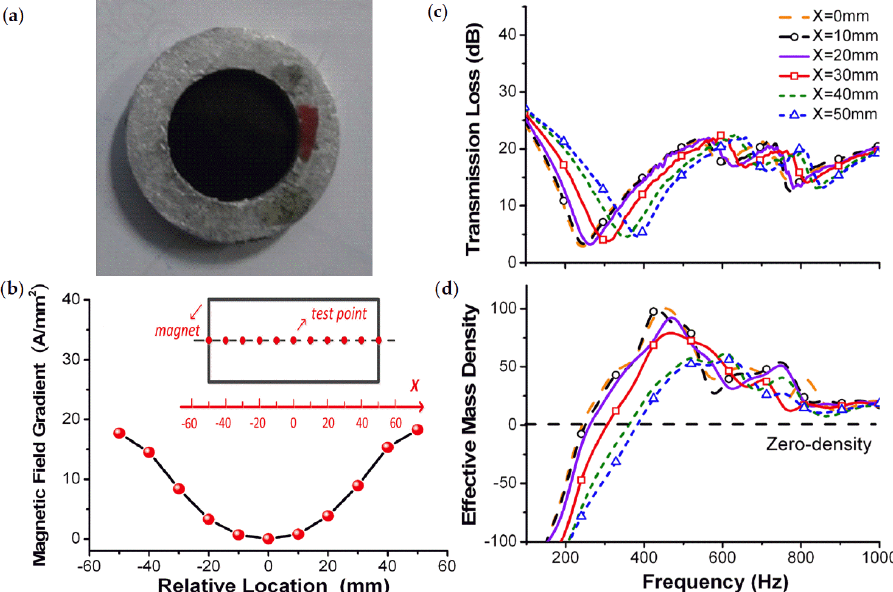
Figure 10. Tunable AMMs with varying magnetic field gradient. ( a ) Schematic front view of the membrane structure (the elastic membrane fabricated with magnetorheological elastomers is fixed by the support frame); ( b ) The magnetic field gradient varies along the axial direction. Inset: The schematic of test points; ( c ) The measured STL; and ( d ) Effective mass density spectra in different gradient magnetic fields. Adapted with permission from [148], AIP Publishing, 2014.